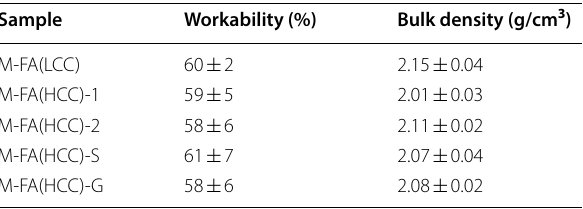
Table 3 Workability and bulk density of the different mortars at 28 days of